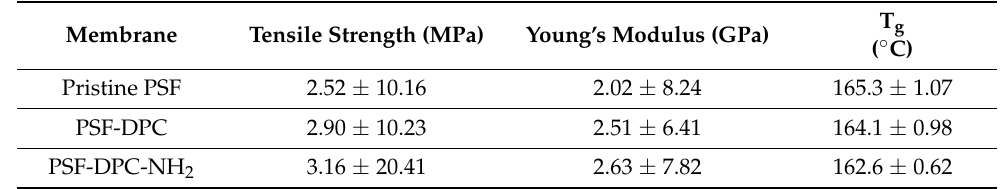
Table 3. Mechanical and thermal properties of the optimum membranes.